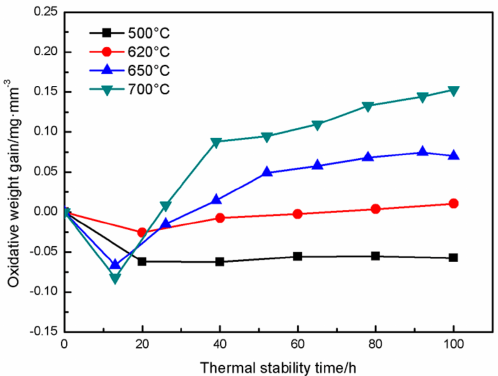
Figure 8. Effect of oxidation temperature and time on oxidation weight gain of the CuAl seal